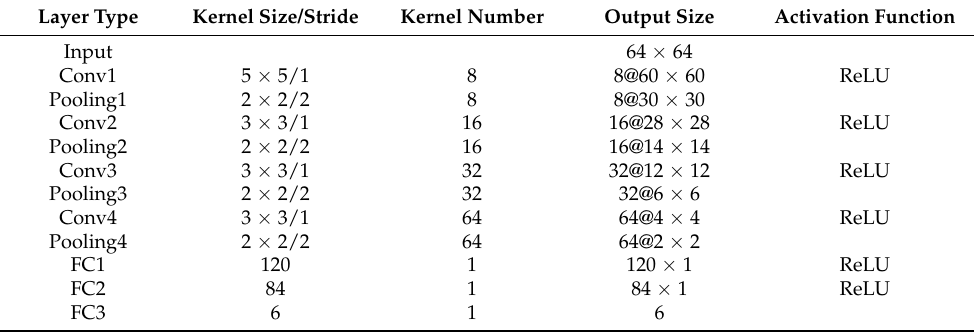
Table 3. Detailed settings of the